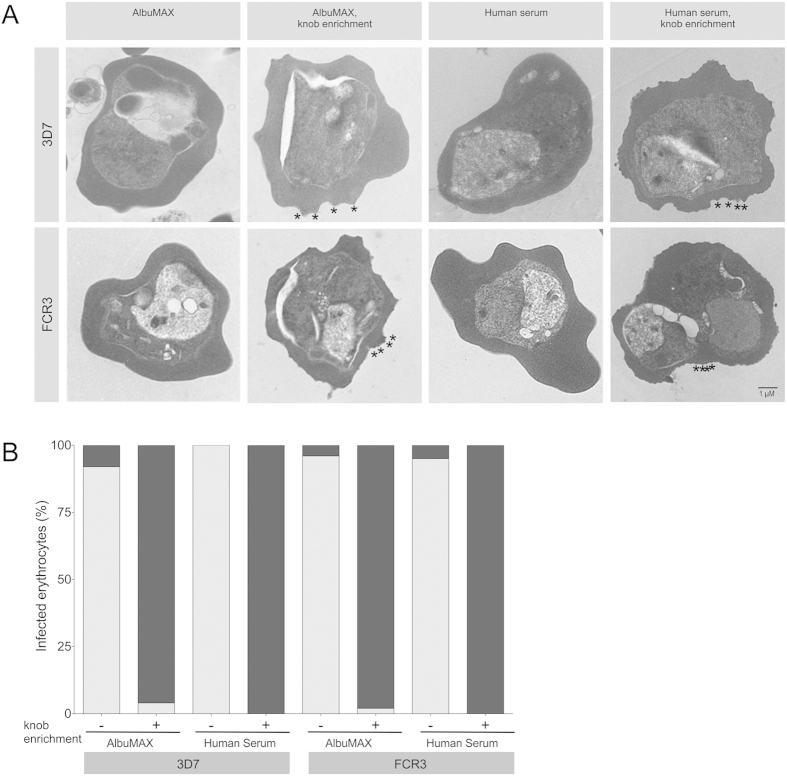
Transmission electron micrographs showing P. falciparum infected erythrocytes (IEs).The isolates 3D7 and FCR3 were cultivated in the presence of AlbuMAX (0.5%) or human serum (10%). In addition, isolates were subjected to gelatin sedimentation to enrich knobby IEs. A. Morphology was analyzed by transmission electron microscopy. For each type of cultivation one IE was shown as an example. Knobs are marked exemplarily by stars. B. Quantification of knobby IEs. Between 25 and 40 IEs per culture were analyzed for the presence of knobs. Gray column, knobless IEs; black column, knobby IEs.